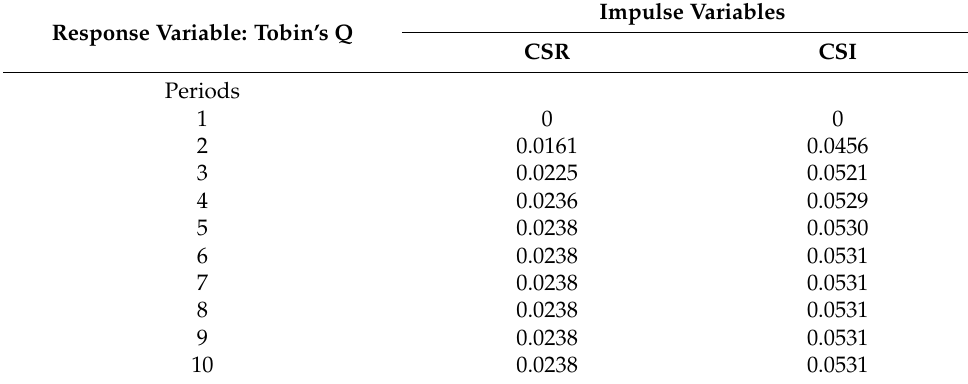
Table 6. FEVD of financial performance according to CSR and CSI.